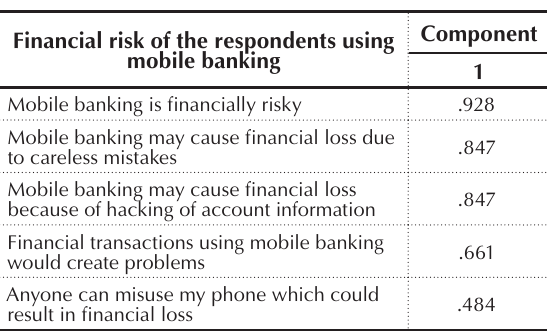
Table 6. (cid:38)(cid:258)(cid:272)(cid:410)(cid:381)(cid:396)(cid:3)(cid:258)(cid:374)(cid:258)(cid:367)(cid:455)(cid:400)(cid:349)(cid:400)(cid:3)(cid:381)(cid:374)(cid:3)(cid:410)(cid:346)(cid:286)(cid:3)(cid:302)(cid:374)(cid:258)(cid:374)(cid:272)(cid:349)(cid:258)(cid:367)(cid:3)(cid:396)(cid:349)(cid:400)(cid:364)(cid:3)(cid:3) (cid:381)(cid:296)(cid:3)(cid:410)(cid:346)(cid:286)(cid:3)(cid:396)(cid:286)(cid:400)(cid:393)(cid:381)(cid:374)(cid:282)(cid:286)(cid:374)(cid:410)(cid:400)(cid:3)(cid:437)(cid:400)(cid:349)(cid:374)(cid:336)(cid:3)(cid:373)(cid:381)(cid:271)(cid:349)(cid:367)(cid:286)(cid:3)(cid:271)(cid:258)(cid:374)(cid:364)(cid:349)(cid:374)(cid:336)